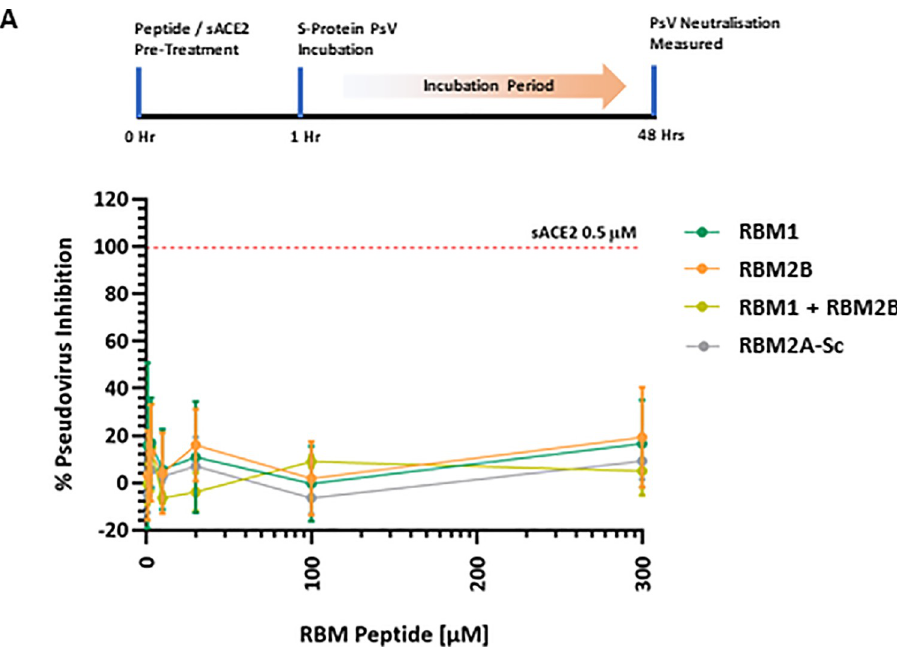
Fig 6. Spike protein (full-length trimer, Wuhan-Hu-1 strain) pseudovirus neutralisation assay in human ACE2 overexpressing HEK293T cells. RBM peptides were pre-treated (1 hour) at 300 μ M, 100 μ M, 30 μ M, 10 μ M, 3 μ M and 1 μ M, followed by 48-hour co-incubation with spike protein PsV (luciferase labelled) and subsequent luminescence detection. sACE2 (human ACE2 protein) represents positive PsV neutralisation control. Data represented as MEAN % difference of DMSO only negative control (100%) ± SEM, N = 3 independent experiments. PsV , Pseudovirus .